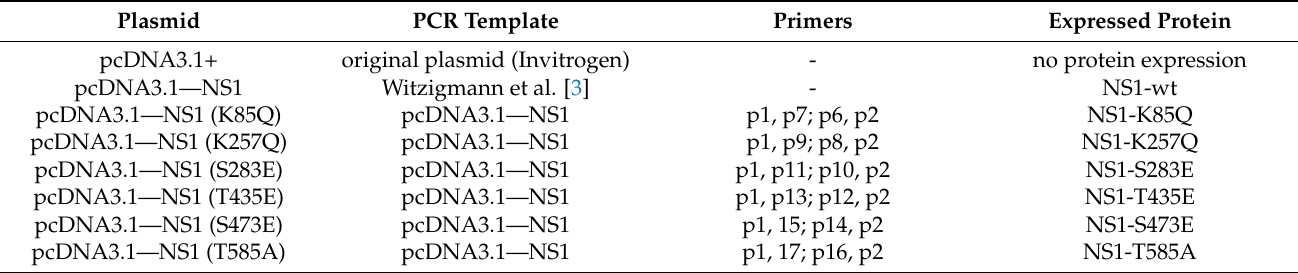
Table 1. Plasmids and Primers used for cloning and mutant